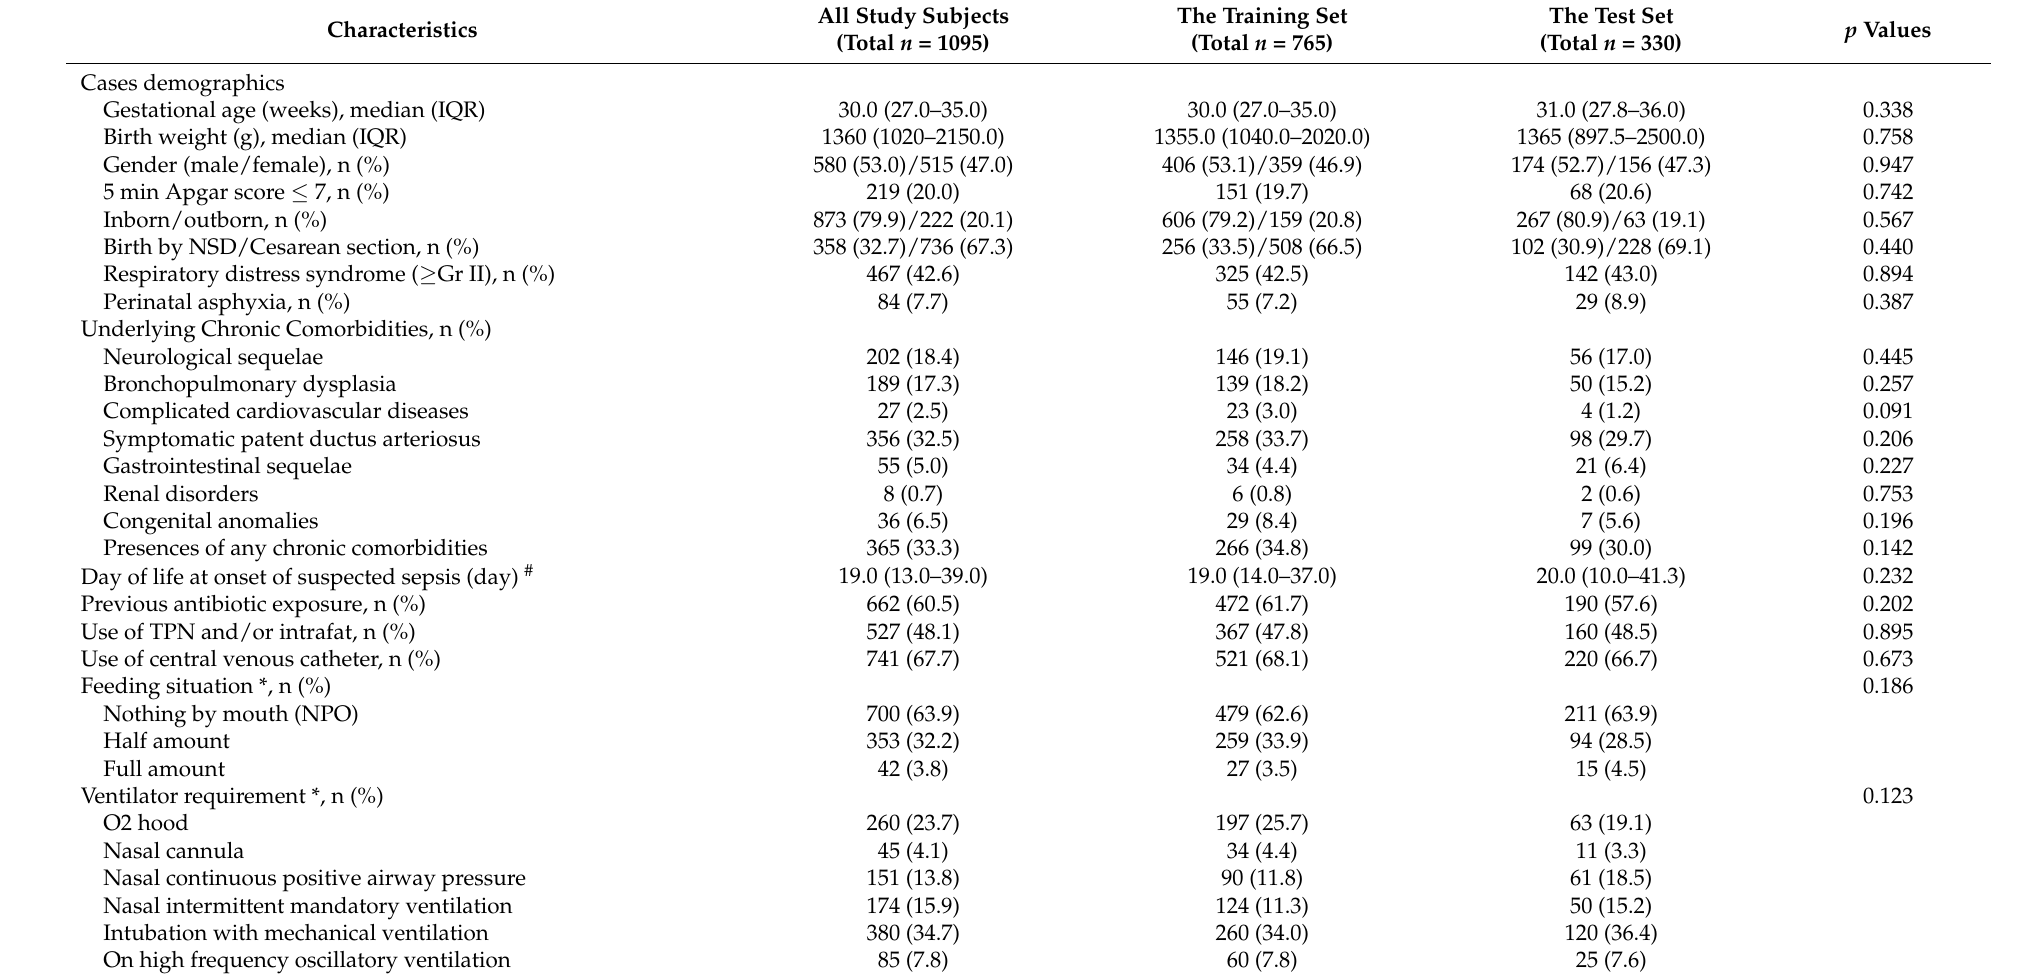
Table 1. Patient demographics, characteristics, and clinical presentation of all neonates with suspected